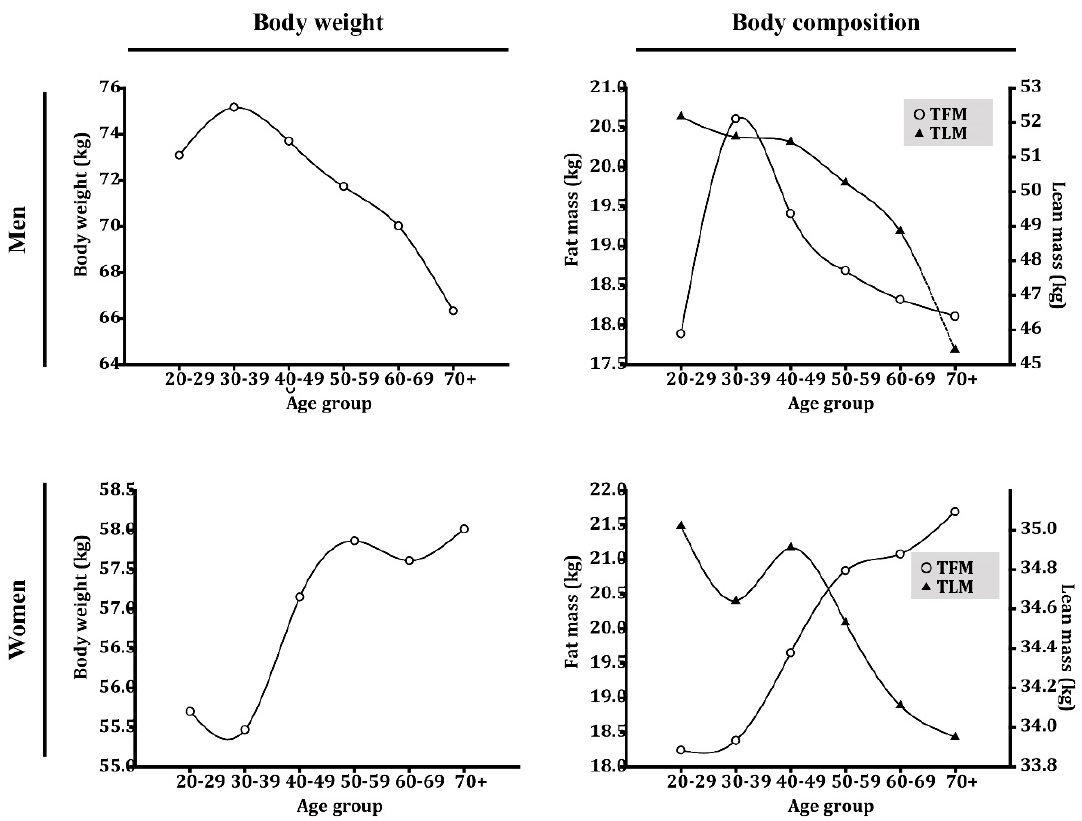
Figure 1. Age-based di ff erences in body weight and body composition in a healthy control population. TFM: total fat mass; TLM: total lean mass.